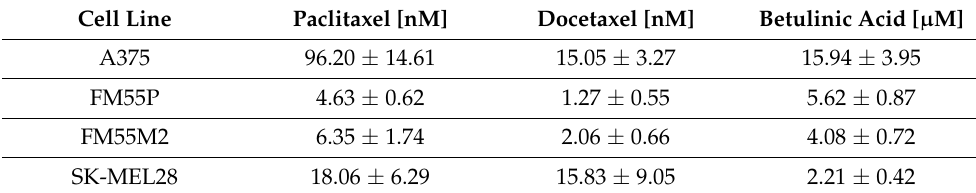
Figure 7. ( A – D ). Log-probit dose-response relationship curves (DRRCs) for betulinic acid (BA) and docetaxel administered alone, and in combinations at the fixed ratio of 1:1 (dotted line), illustrating the anti-proliferative effects of the drugs in malignant melanoma cancer cell lines (A375 ( A ), FM55P ( B ), FM55M2 ( C ), and SK-MEL28 ( D )) measured in vitro by the MTT assay. Table 1. The anti-proliferative effects of betulinic acid (BA), paclitaxel, and docetaxel administered alone in human malignant melanoma cell lines measured in vitro by the MTT assay. Data are median inhibitory concentrations (IC values ±